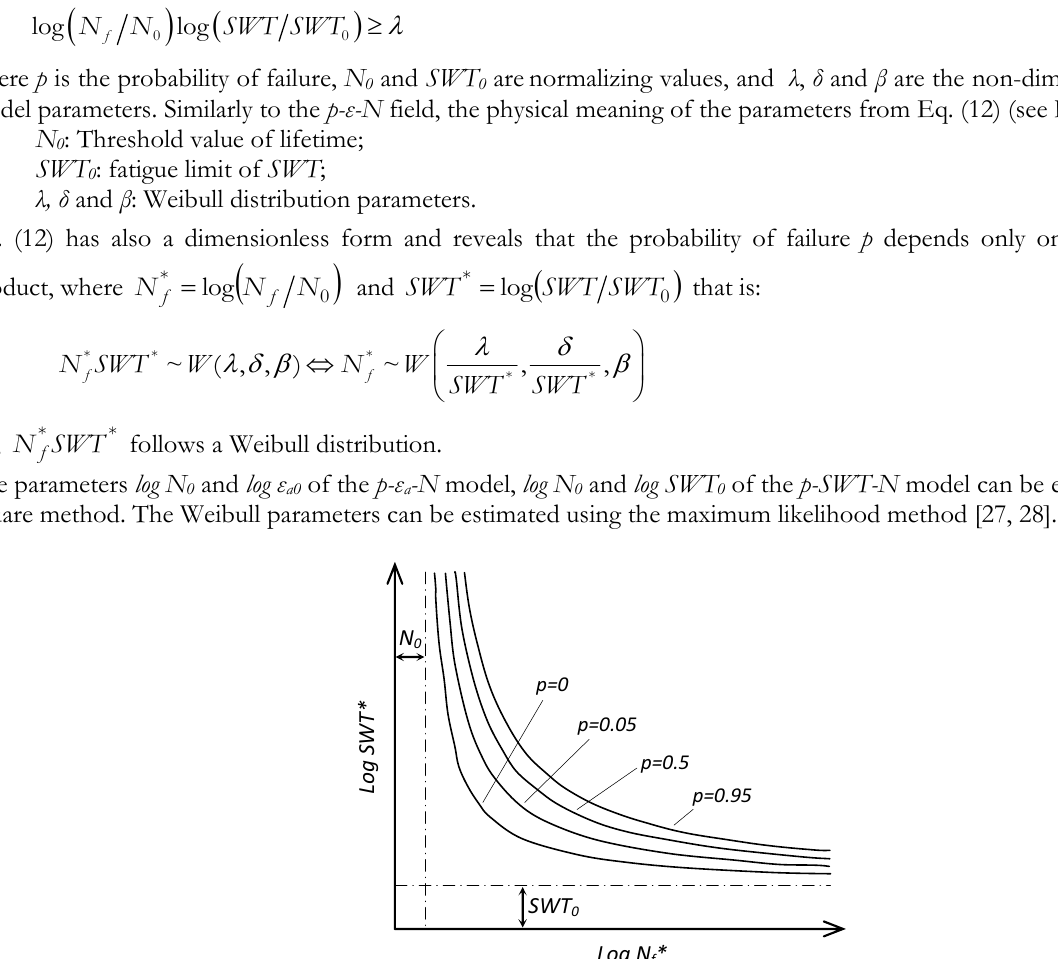
Figure 3: Percentile curves representing the relationship between dimensionless lifetime, N SWT - N f